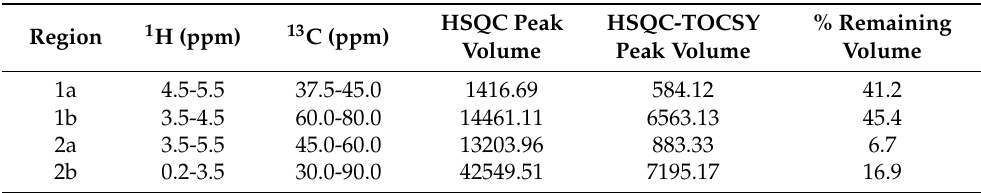
Table 1. Peak volume between glycan dominant (1a/1b) and protein dominant (2a/2b) spectral